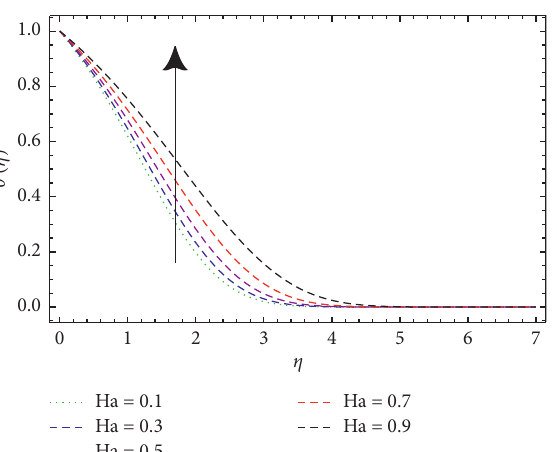
Figure 9: Influence of the temperature θ ( η ) profile via Ha.